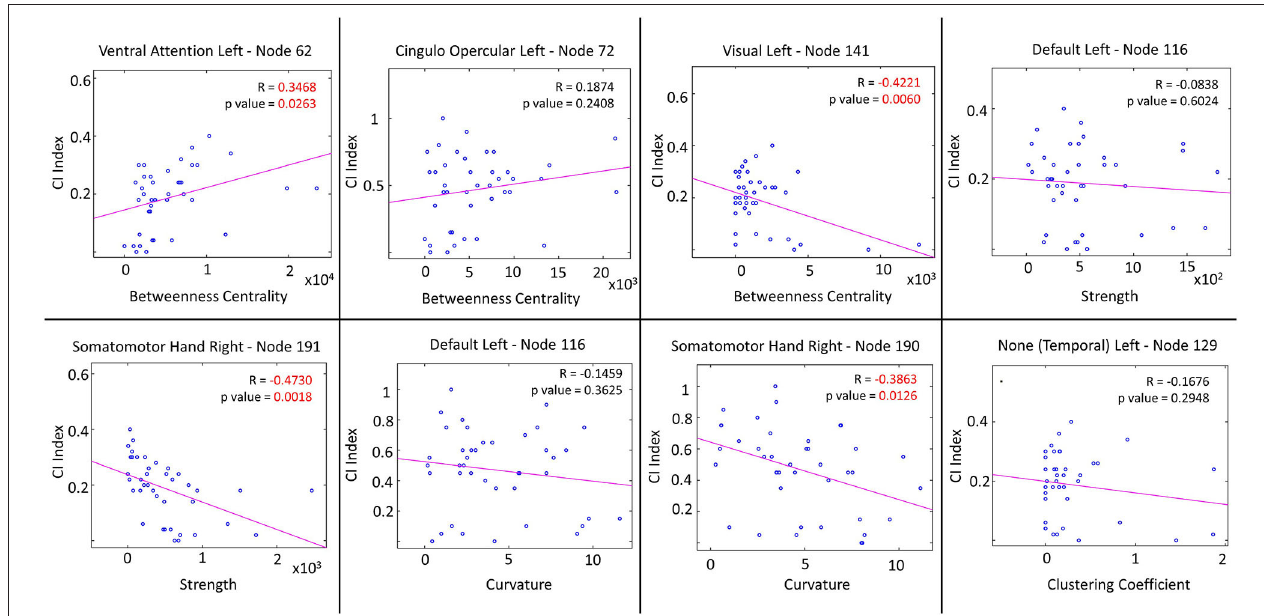
FIGURE 3 | Correlation plots between cognitive impairment (CI) index and network local measures, for brain areas showing significant differences between MSCI and MSNI patients. Plots with significant p -values (shown in red) show positive correlation between CI and betweenness centrality in a node from the ventral attention network. A negative correlation between CI and betweenness centrality in a node from the visual network, and with strength as well as with curvature in nodes from the somatomotor (hand) network is